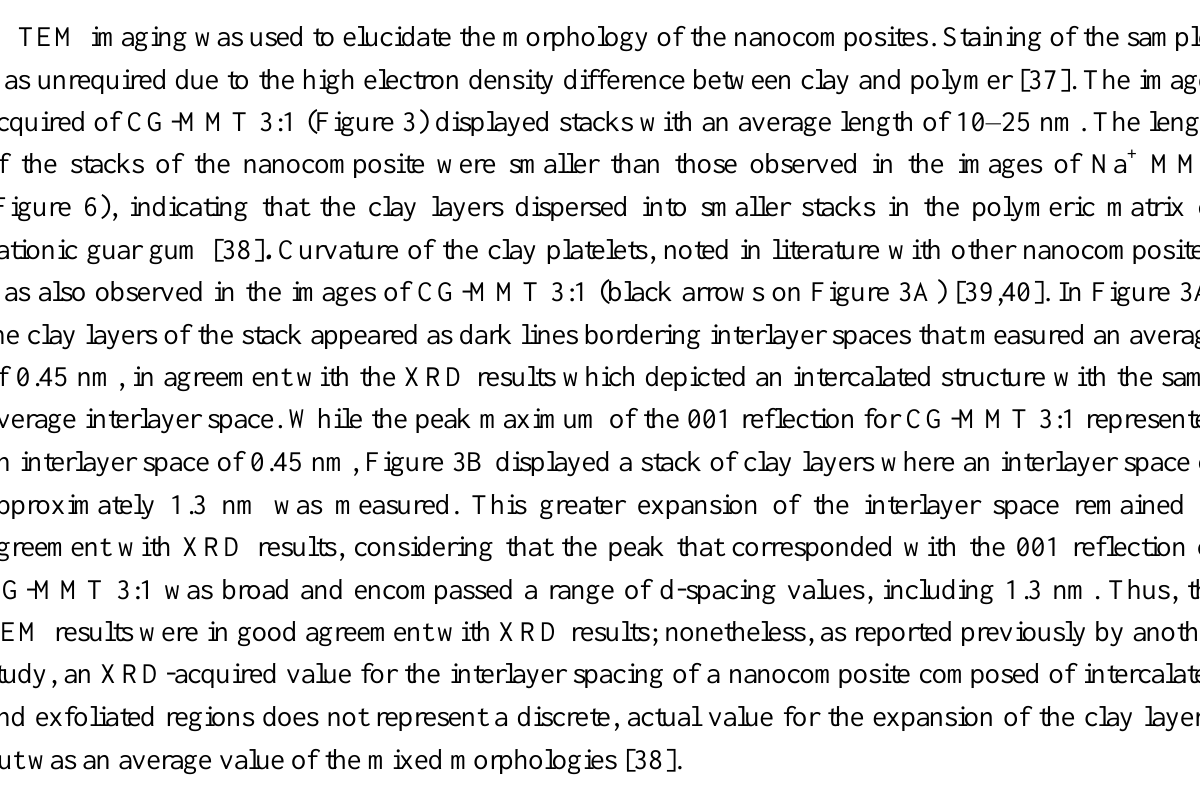
Figure 3. Transmission electron microscopy (TEM) images of CG-MMT